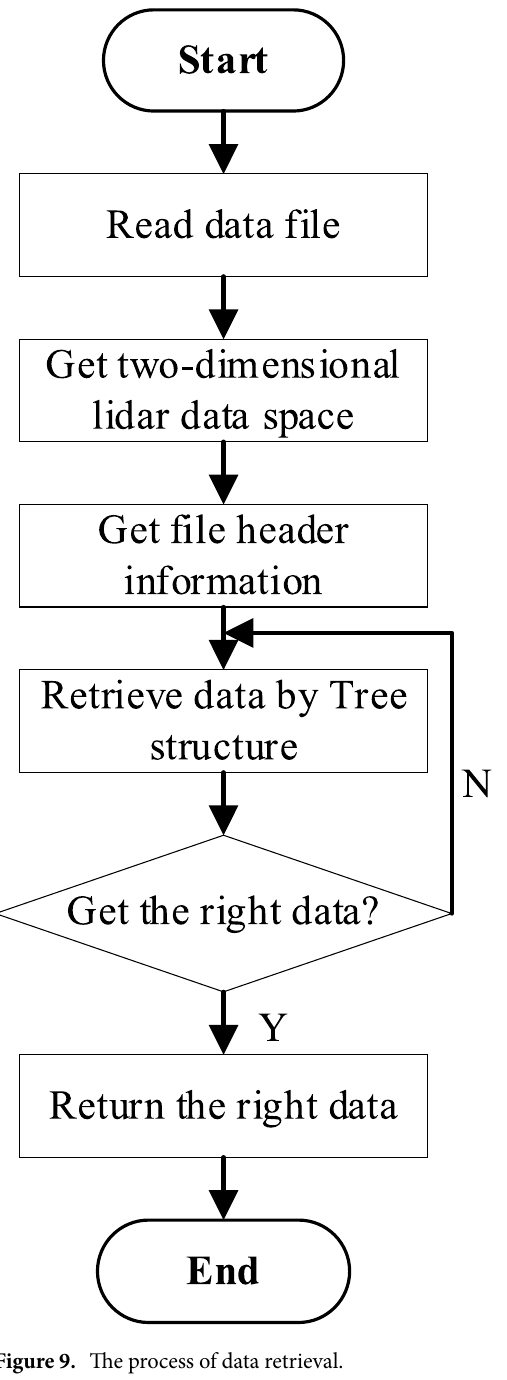
Figure 9. The process of data